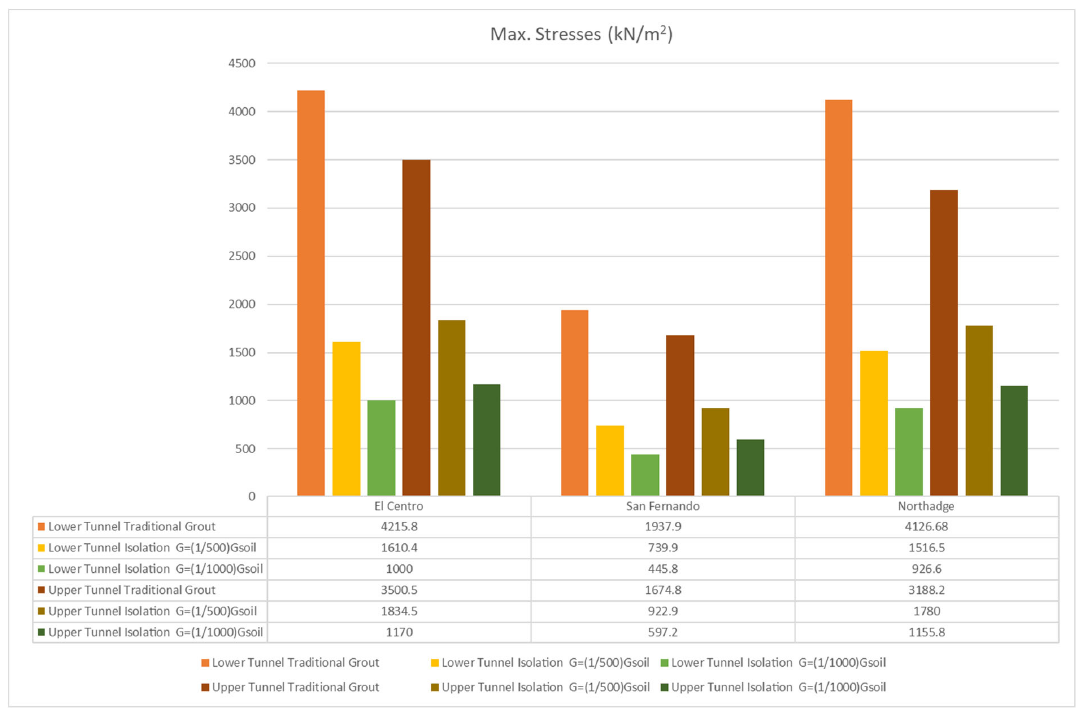
Figure 13. Maximum transverse stresses of the upper tunnel in stiff soil and the lower tunnel in soft soil.